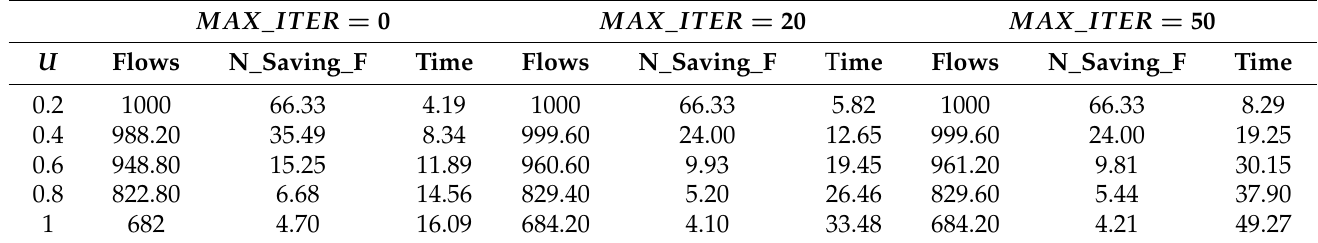
Table 7. 12eight servers-1000 flows-Flow scheduling—Phase 2 Multistart Ad-Hoc.